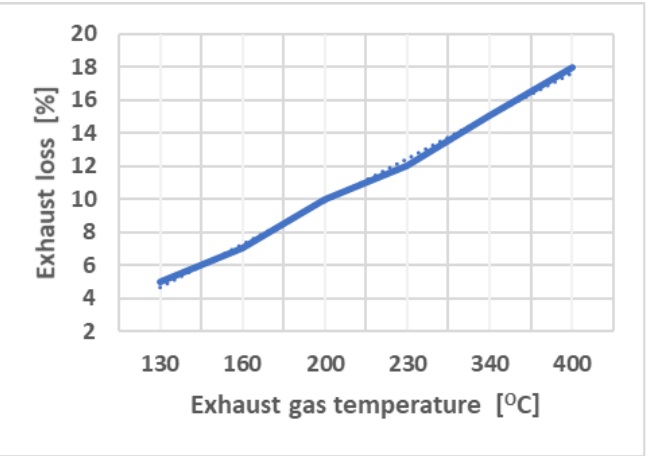
Figure 1. Relation between exhaust gas temperature and boiler’s exhaust loss [own study].